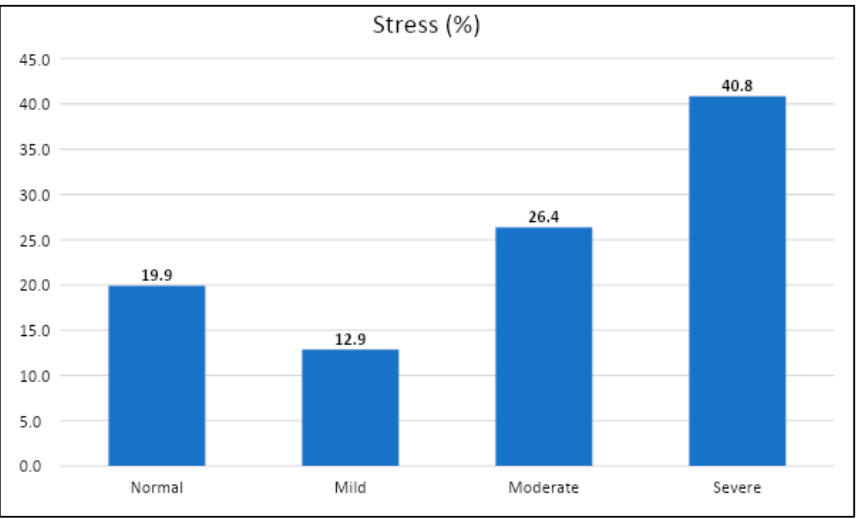
While assessing the rates of stress using the DASS-21 stress scale score among the participants with COVID-19 infection, it was found that 203 (40.8%) had severe stress scores (severe and extremely severe scores merged), while 131 (26.4%) had moderate stress scores (Figure 1).